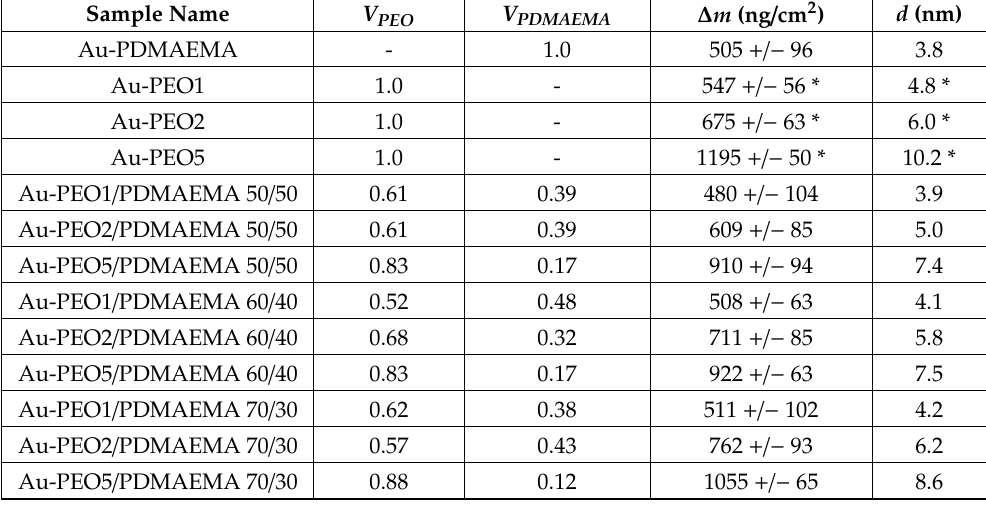
Table 1. Characterization of Polymer Coatings Formed on Gold